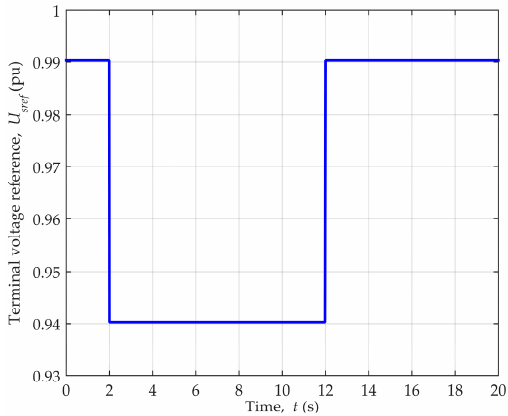
Figure 7. Terminal voltage reference change for generator operating point P = 0.89, Q = 0.